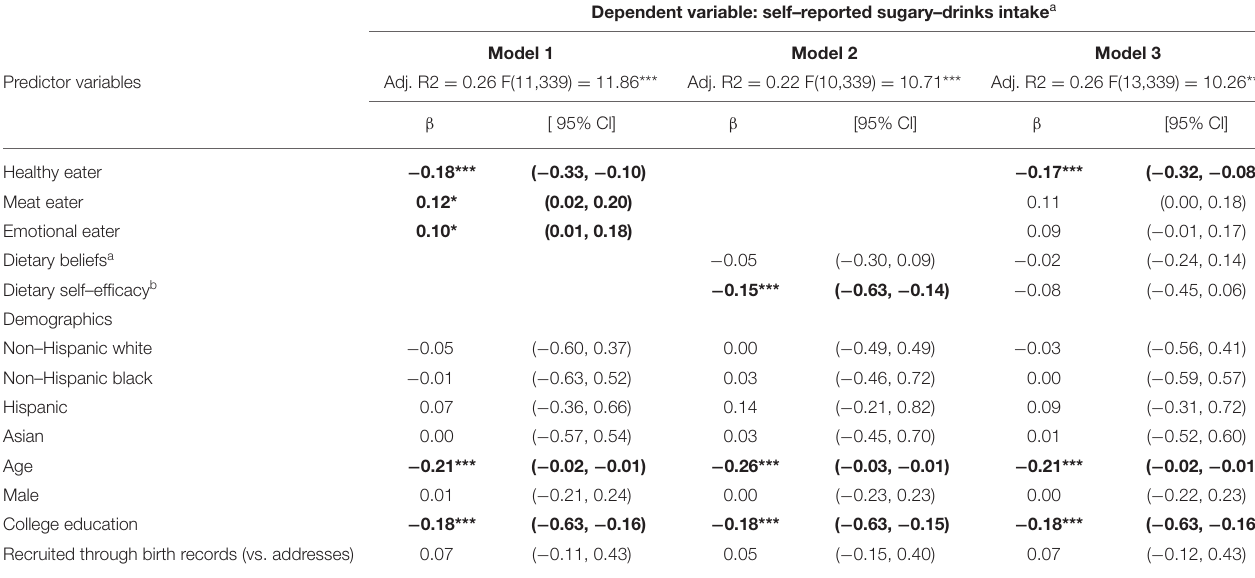
Dependent variable: self–reported sugary–drinks intake